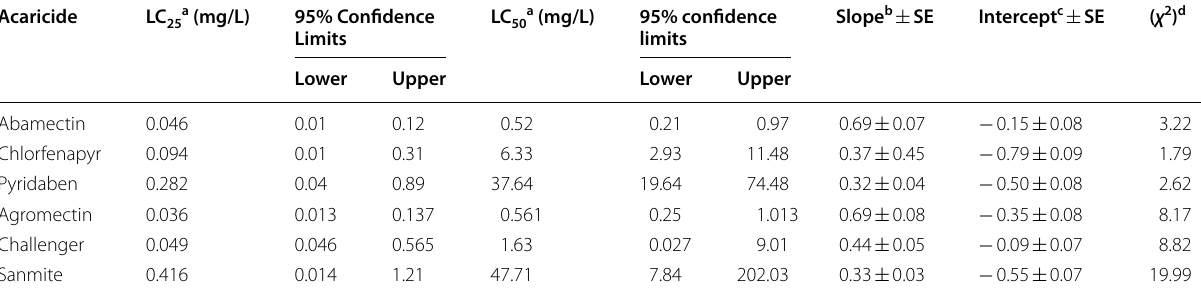
Table 3 Acaricidal activity of technical (abamectin, chlorfenapyr, and pyridaben) and formulated (Agromectin, Challenger, and Sanmite) acaricides against adults of two-spotted spider mite T. urticae after 48 h by slide-dip technique